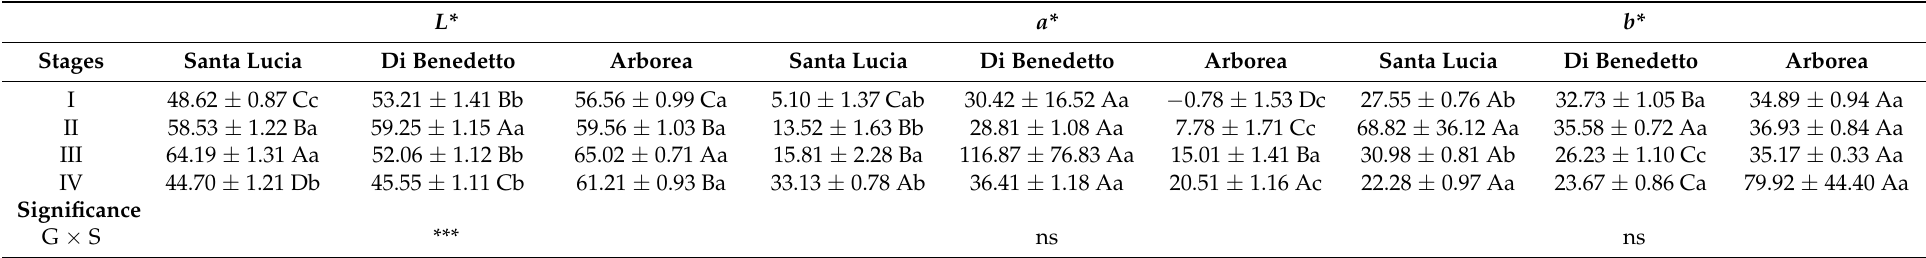
Table 3. Color attributes ( L* , a* , b* ) of three pomegranate genotypes (‘Santa Lucia’, ‘Di Benedetto’, and ‘Arborea’) at different ripening stages